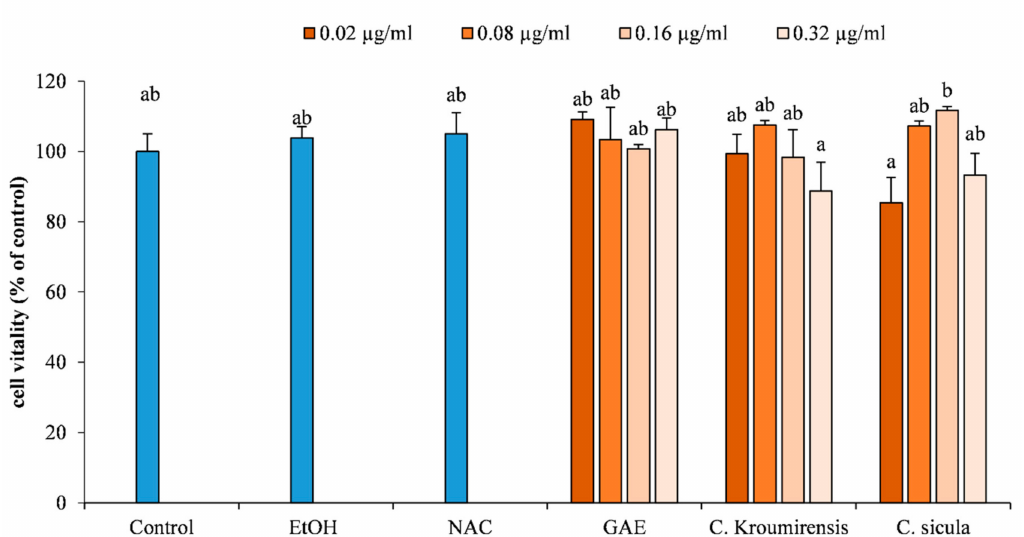
Figure 4. Percentage of vitality of HS-68 fibroblast cells, obtained with MTT test (each data is presented as mean ± SD, n = 5). Cells treated with UE extracts of ( C. kroumerienis and C. sicula ) for 24 h to concentrations 0.02, 0.08, 0.16 and 0.32 µ g / mL (0.1% < ethanol). Control (cells without treatment) (Di ff erent letters indicate significant di ff erence ( p < 0.05)).